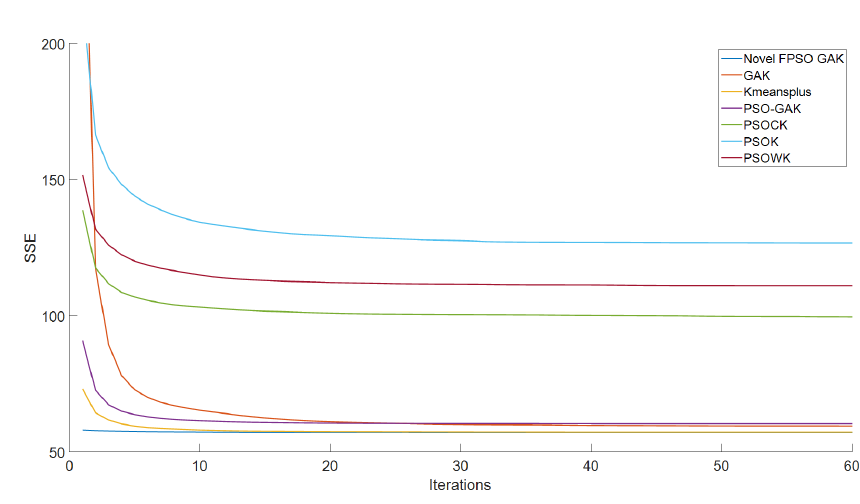
Figure 12. The SSE convergence curve of taxi GPS dataset from Roma